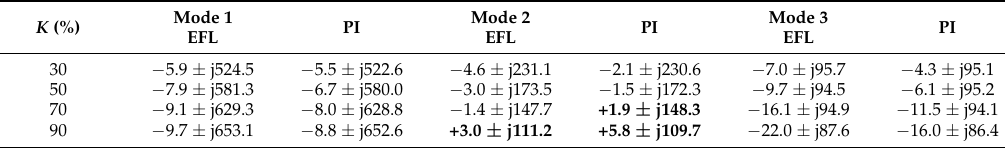
Table 2. System modes at a wind speed ( V wind ) of 8